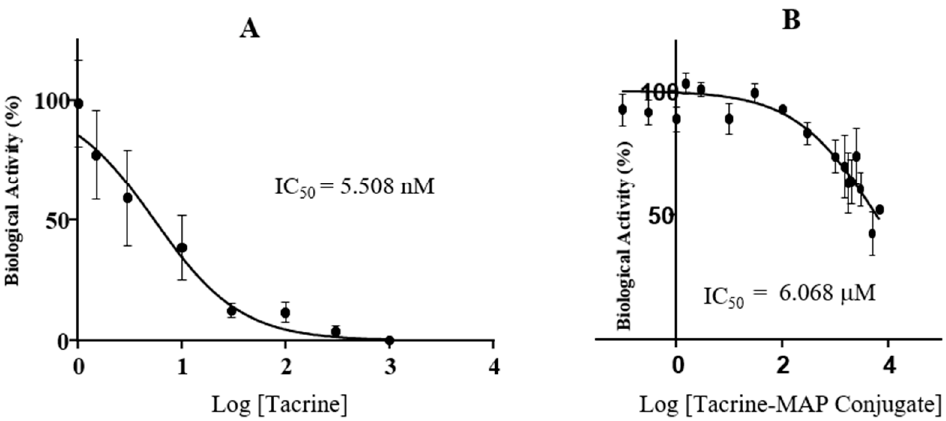
Figure 3. Log [drug] vs. biological activity (%) of Tacrine ( A ) and the conjugate ( B ). Results are presented in mean ± standard error of mean (SEM). The IC 50 of each compound is displayed next to the inhibition curves.